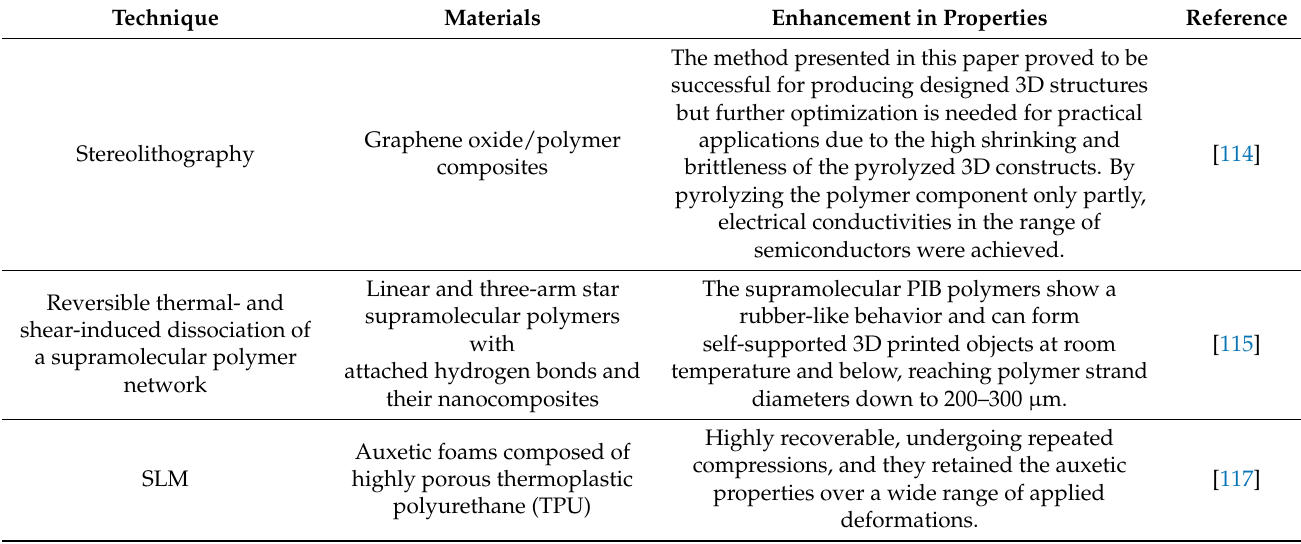
Table 4. Techniques used and properties enhancement in particle reinforced polymer